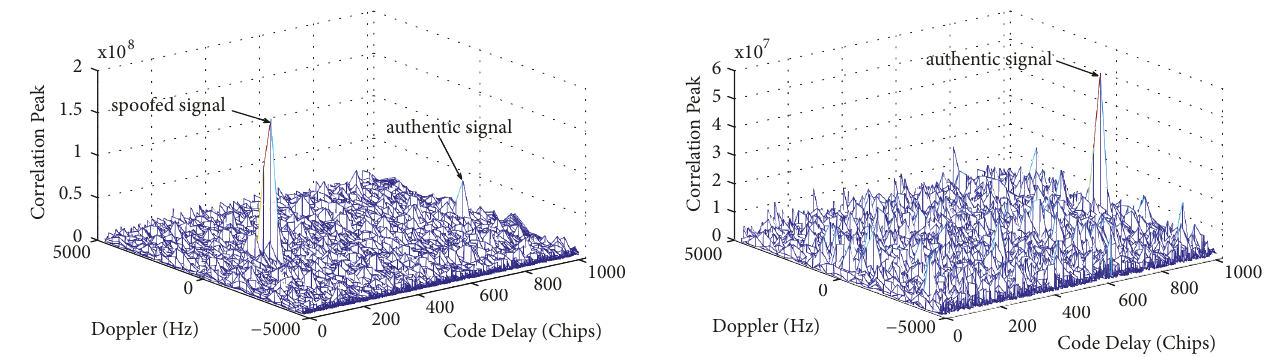
Figure 8: Acquisition of PRN25 with the proposed AJ-AS.